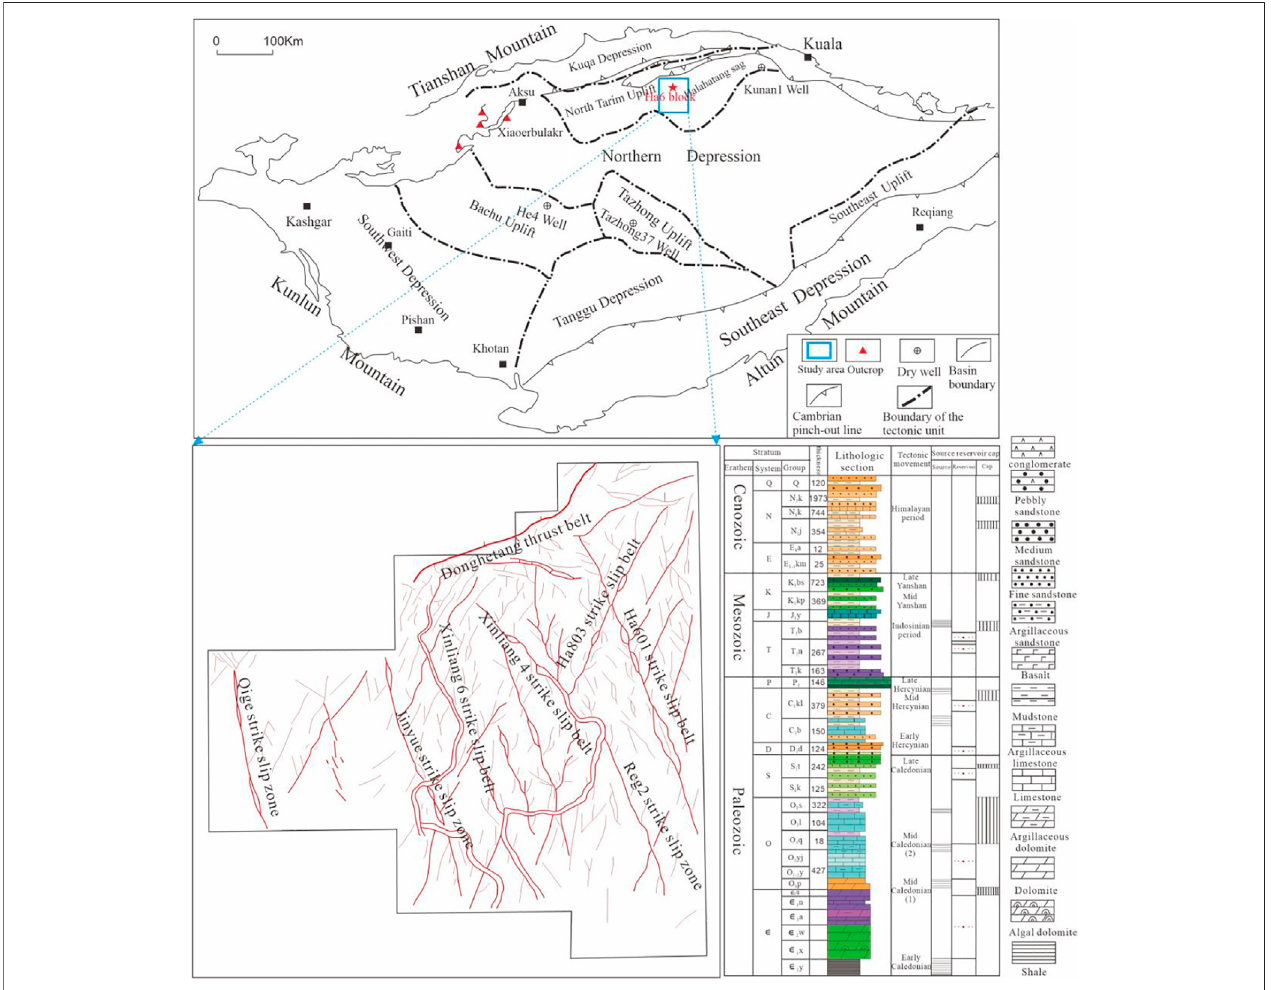
FIGURE 1 | Outline map of Ordovician faults in the 3D area of the Liulian block of Halahatang (modi fi ed from Li et al., 2021).